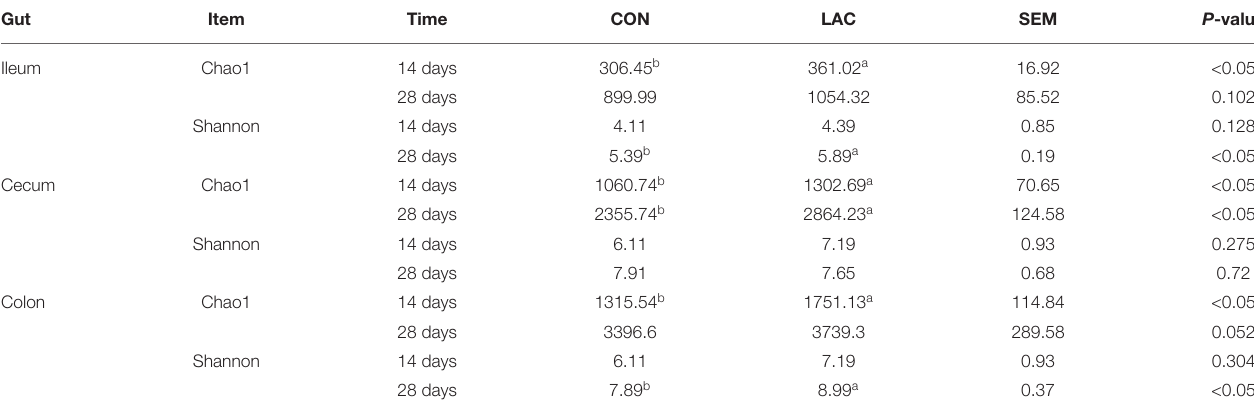
TABLE 4 | Effects of Lactobacillus delbrueckii on the α -diversity of the microbiota in the weaned piglets. Gut Item Time CON